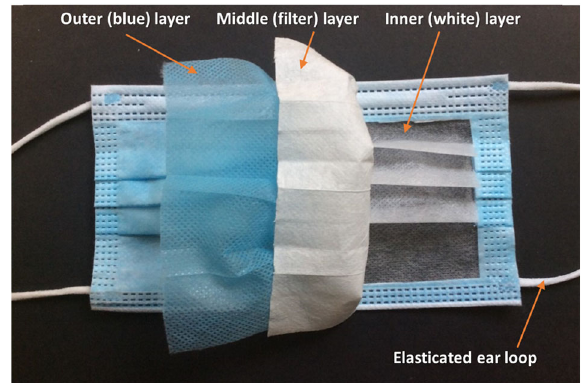
Fig. 1 An image of a surgical mask. The three layers of a typical surgical mask are shown.